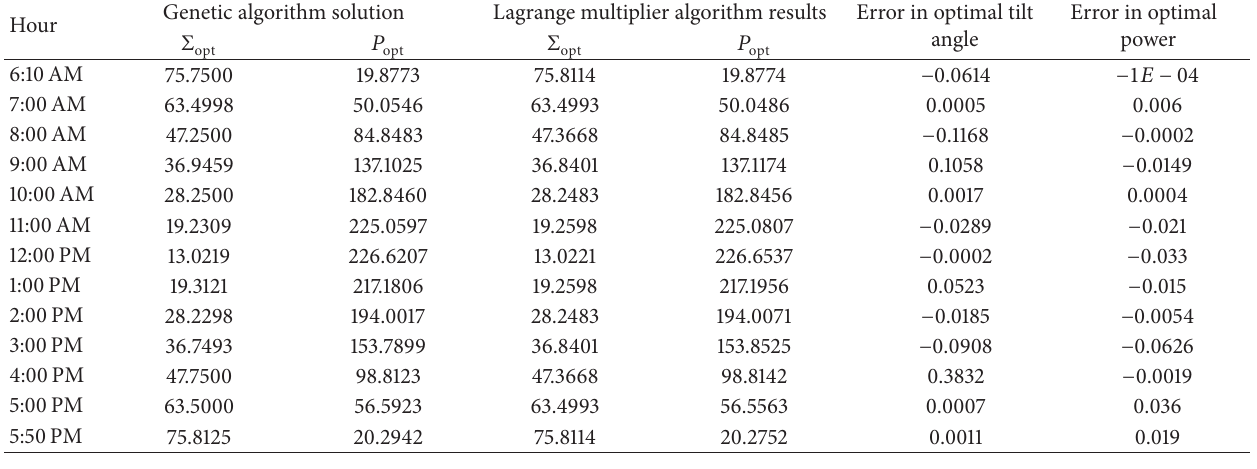
Table 6: A comparison between the GA and Lagrange multiplier algorithm.